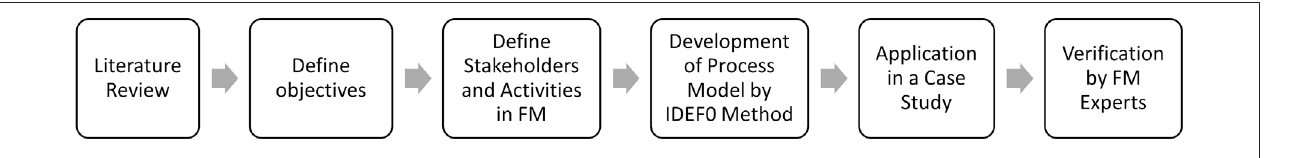
FIGURE 1 | Research